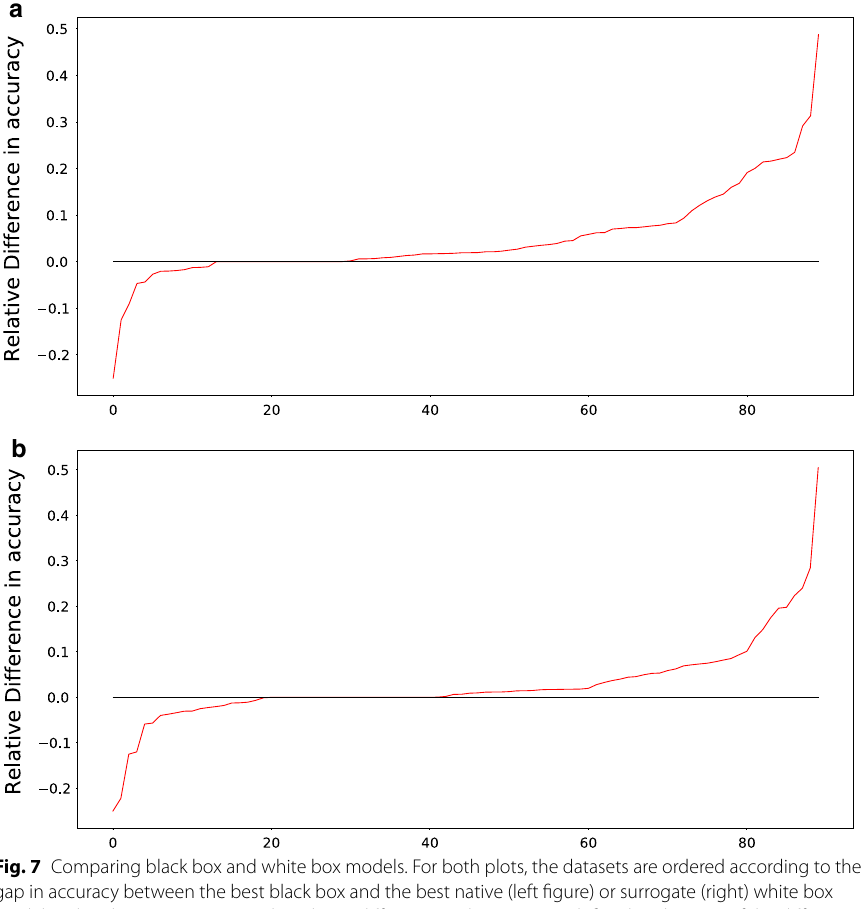
Fig. 7 Comparing black box and white box models. For both plots, the datasets are ordered according to the gap in accuracy between the best black box and the best native (left figure) or surrogate (right) white box model (right).The y-axis measures the relative difference in the accuracy, defined as the ratio of the difference between the black and white box accuracy divided by that of the best